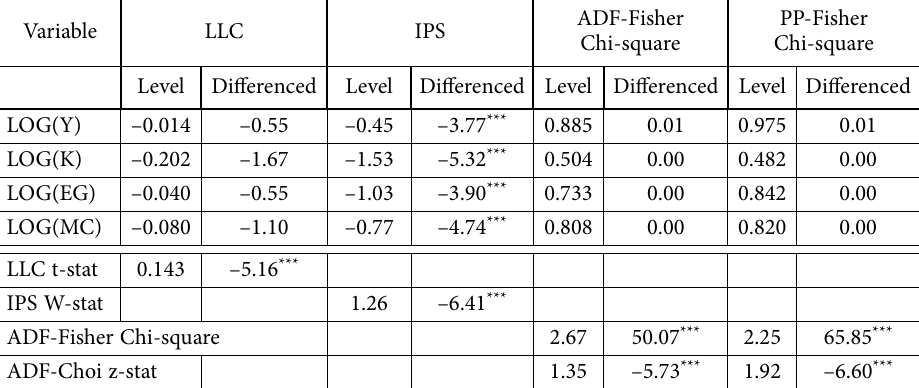
Table 7. Unit root tests (source: authors’ processing based on WBD, Eurostat, ILO and NIS data)